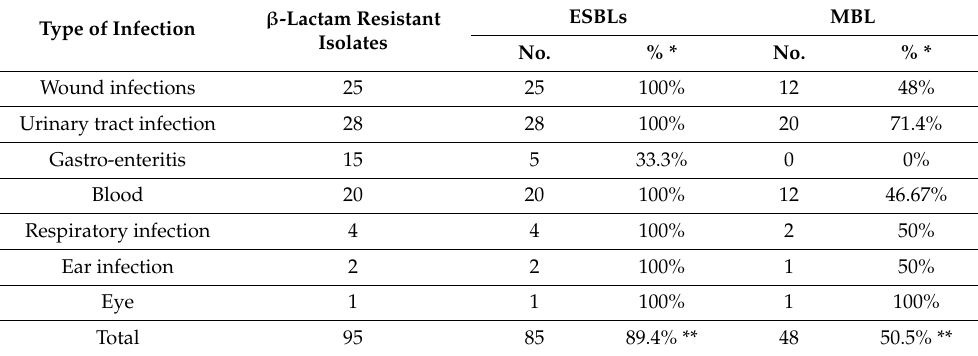
Table 3. Distribution of ESBLs and MBLs producing isolates among clinical specimens.